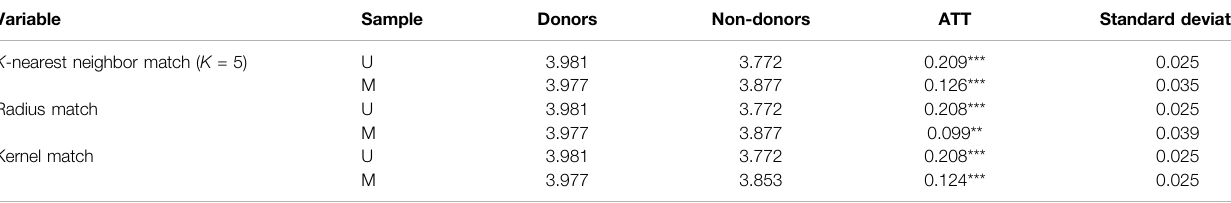
TABLE 5 | Propensity score matching regressions on outcomes. Variable Sample Donors Non-donors ATT Standard